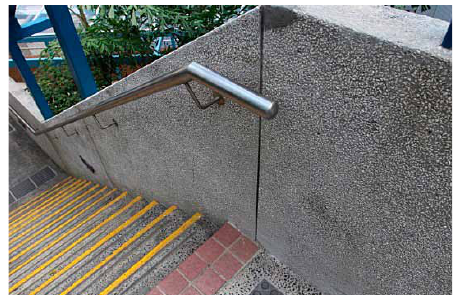
Fig. 7. A lack of braille and tactile information on